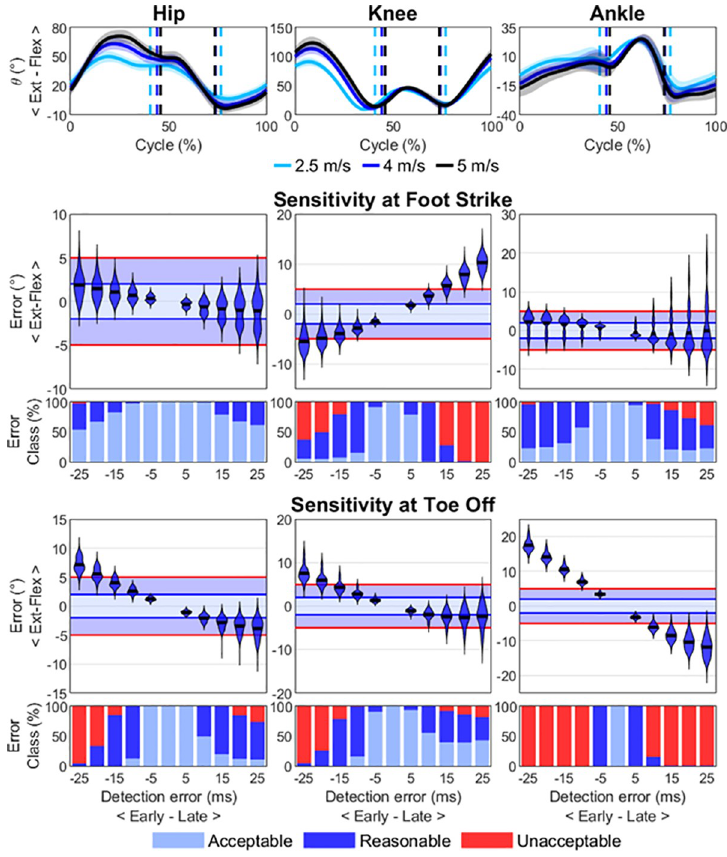
Fig 7. Sensitivity analysis. Top row: mean ( ± standard deviation) hip, knee and ankle sagittal plane angles at 2.5 (cyan), 4 (blue) and 5 (black) m/s during the gait cycle beginning from highest foot COM position to highest foot COM position. Average foot-strike and toe-off are indicated with vertical dashed lines to aid interpretation. More positive angles refer to dorsiflexion in the ankle plot. Using 4 m/s as example, the violin plots show the error (˚) distribution in hip, knee and ankle sagittal plane angles at foot-strike (2nd row) and toe-off (4th row) as a function of anticipated (negative time values on the x axis) or delayed (positive time values) step event detection, where the correct value of the variable is taken from the event time provided by the “gold standard” method (force plate). The horizontal black line within each violin represents the mean. Error classification in acceptable (light blue), reasonable (dark blue) and unacceptable (red) are displayed for foot-strike (third row) and toe-off (fifth row) respectively.